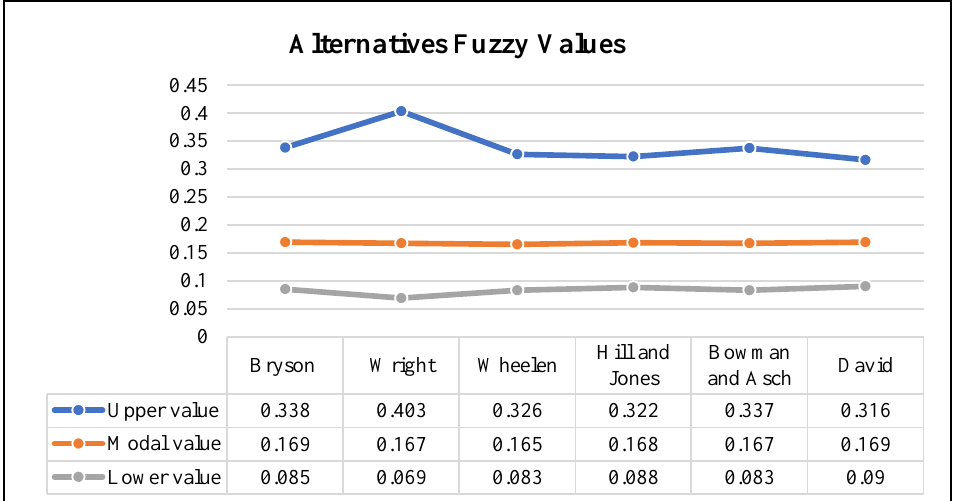
Figure 2. Final fuzzy values of alternatives.